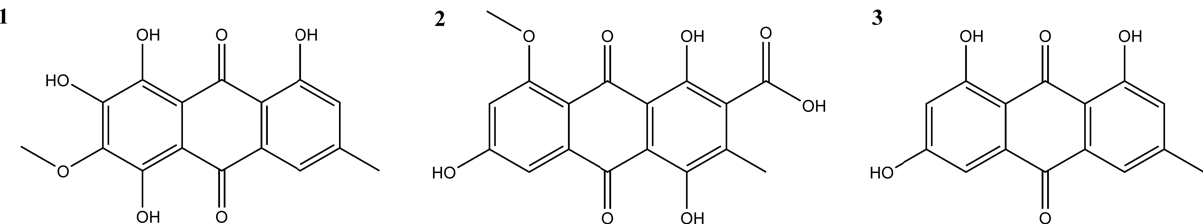
Figure 1. The chemical structures of the dyes present in Cortinarius sanguineus : ( 1 ) dermocybin, ( 2 ) dermorubin and ( 3 ) emodin.